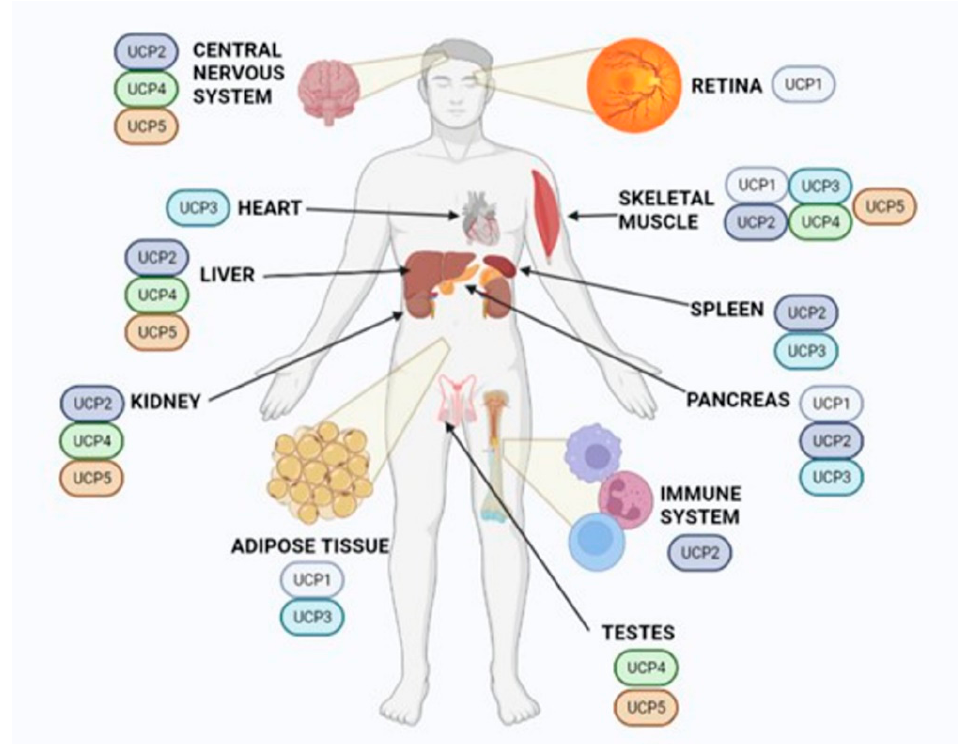
Figure 2. Uncoupling proteins (UCPs) are located in the mitochondria of many tissues. Apart from having tissue-specific roles, UCPs are known for their protective antioxidative activity. See the main text for details. Created with BioRender.com.